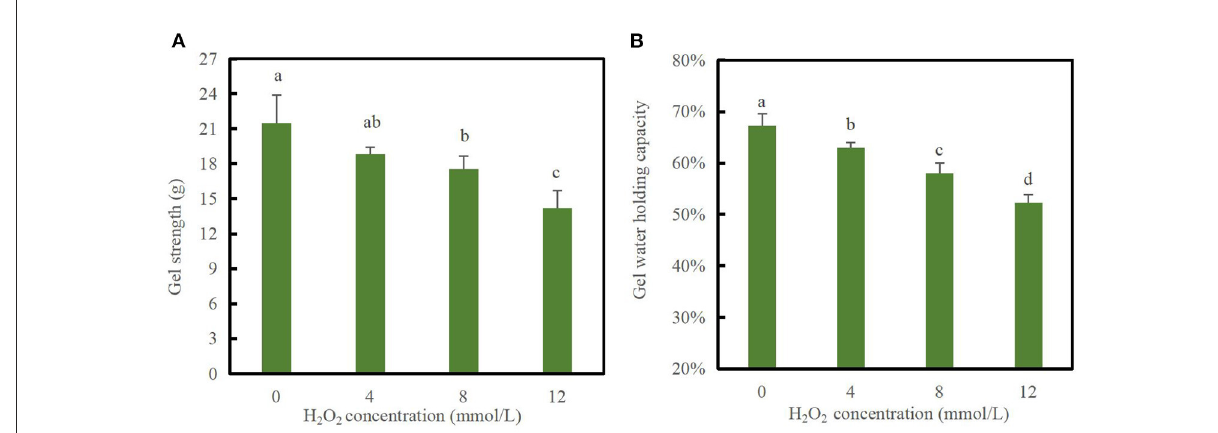
FIGURE3 Changes in gel strength (A) and water-holding capacity (B) of duck myofibrillar protein (DMPs) gels pretreated with various hydroxyl radical levels (H 2 O 2 concentrations: 0, 4, 8, 12 mmol/L). Different lowercase letters (a–d) indicate significant differences between the treatment and control groups ( p <